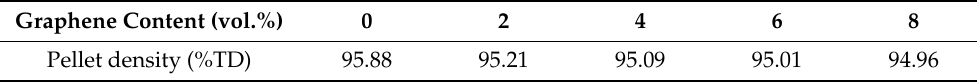
Table 2. Relationship between graphene level and pellet density (%TD).